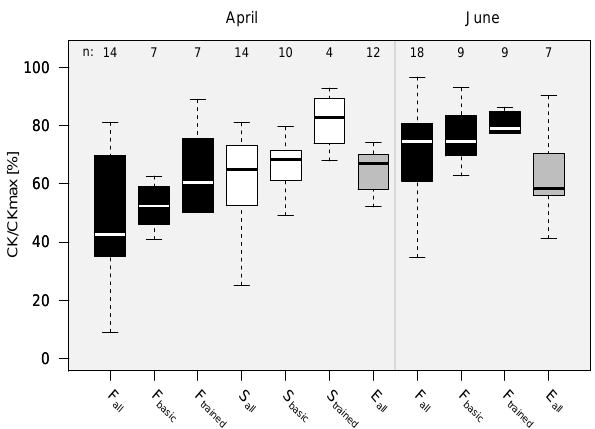
Figure 5. Inter-rater reliability among members of individual groups tested in April and June expressed as the Cohen’s kappa ra- tio CK / CK max ( F : farmers, black, S : students, white, E : experts, grey; ” basic ” indicates the subgroup with only basic introduction, “ trained ” indicates the subgroup with more detailed training, “ all ” indicates that both subgroups have been considered; n : number of individuals in each group).